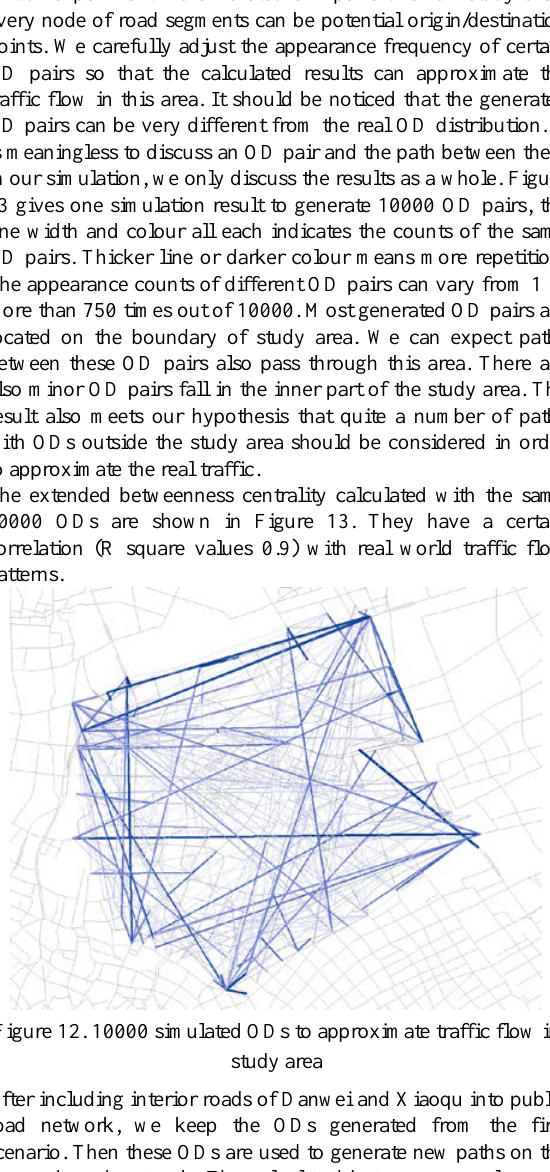
Figure 10. The GPS points in the test area.